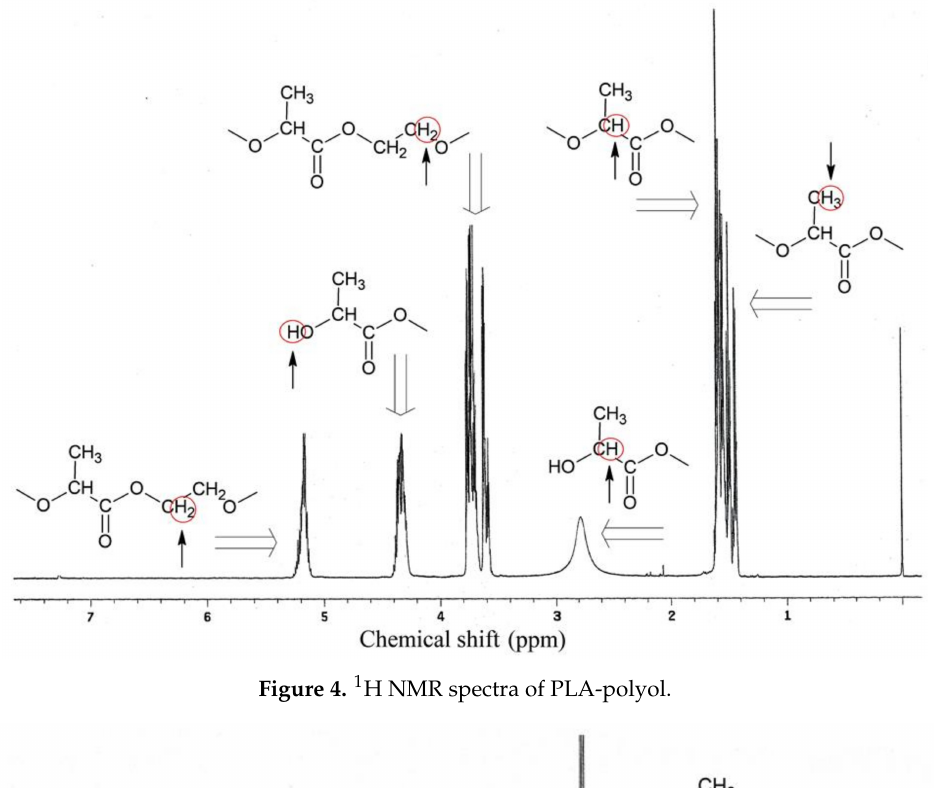
Figure 4. 1 H NMR spectra of PLA-polyol.